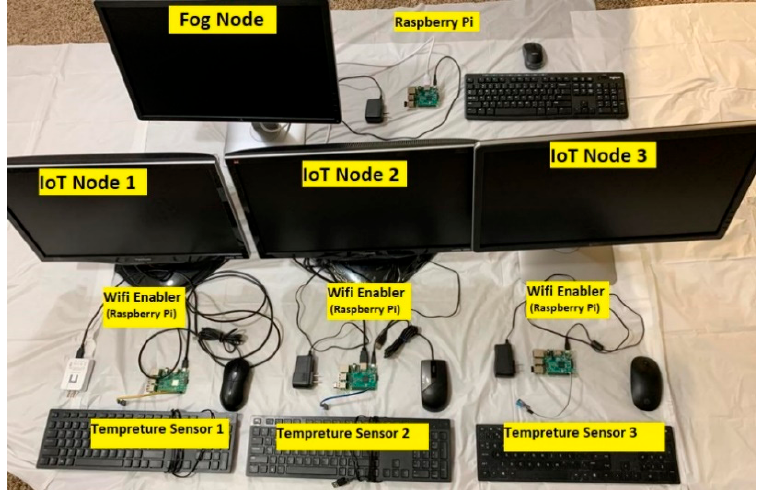
Figure 3. Hardware used in the first architecture (IoT–fog–cloud).